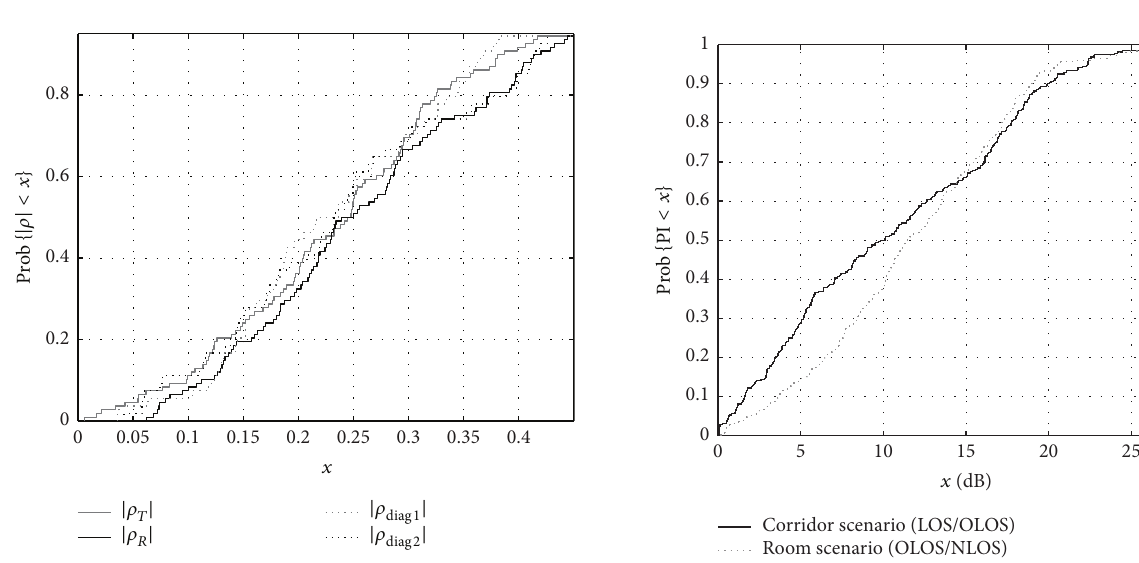
Figure 1: Uniform, 2D 8×8 i-MIMO DAS coverage. Left: no-shift interleaved coverage solution. Center: 1-shift interleaved coverage solution. Right: 2-shift interleaved coverage solution. The 2 by 4 branch “cluster” is highlighted in black. Each color/letter corresponds to a different MIMO branch-signal.